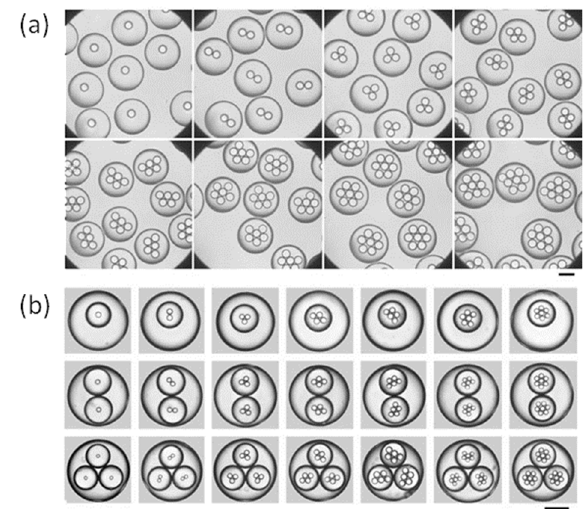
Figure 13. ( a ) Optical micrographs of double emulsions that contain a controlled number of inner droplets; ( b ) Optical micrographs of triple emulsions that contain a controlled number of inner and middle droplets. The scale bar in all images is 200 μ m. Pictures are from [136]. Reproduced with permission from Chu, L.-Y., et al., Angewandte Chemie International Edition ; published by John Wiley and Sons, 2007.